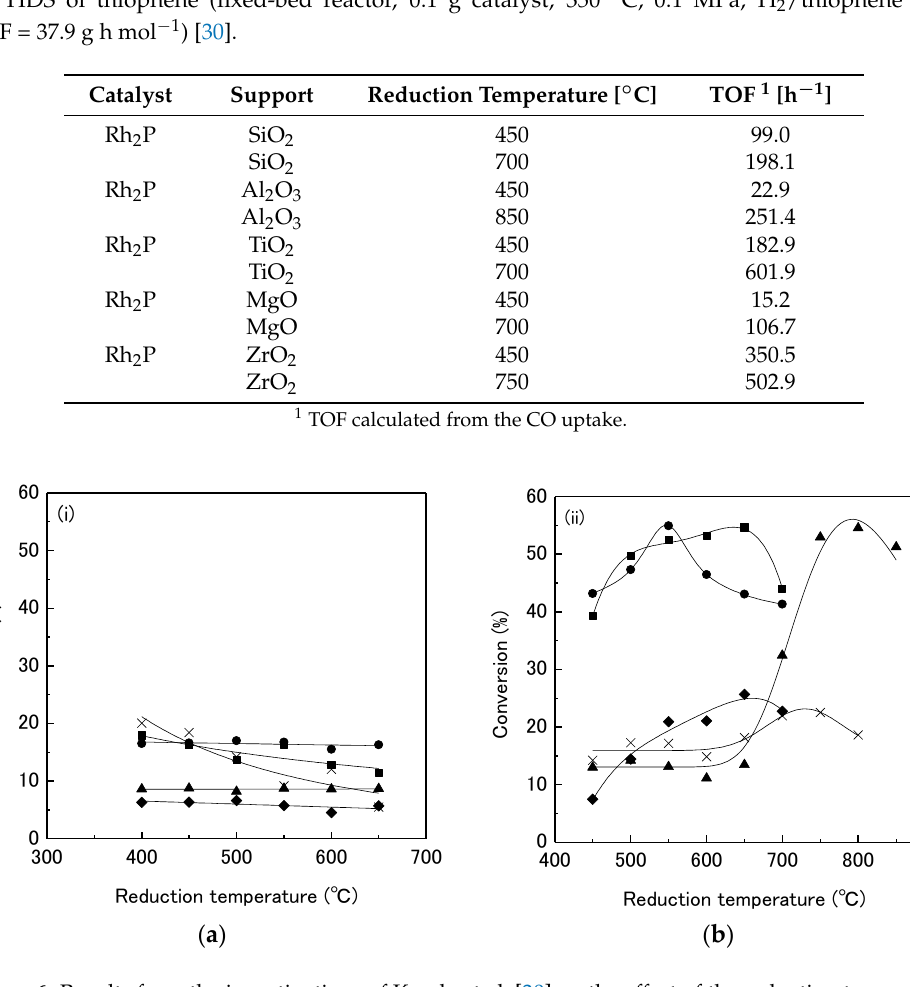
Figure 6. Results from the investigations of Kanda et al. [30] on the effect of the reduction temperature on the conversion of thiophene: ( a ) Rh supported on different support materials; and ( b ) Rh 2 P supported on different materials. Printed with permission of [30].